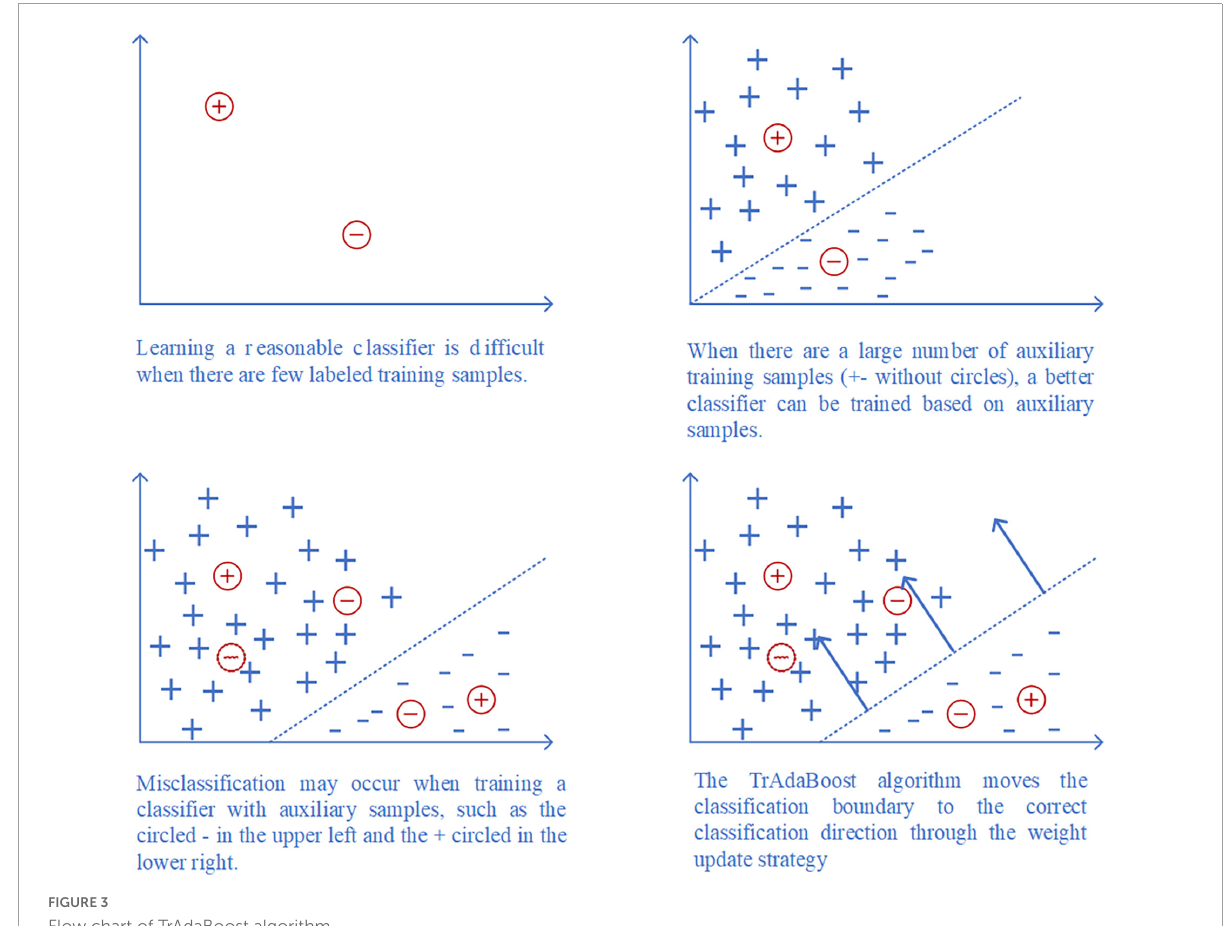
FIGURE3 Flow chart of TrAdaBoost